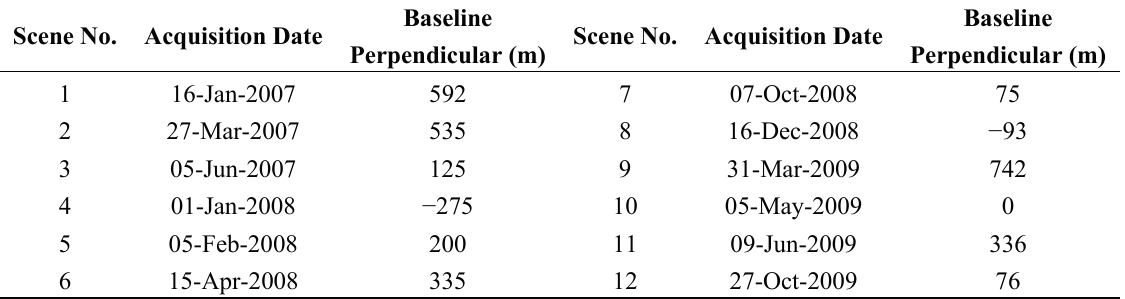
Table A2. SAR images used from Track 404 (Reference date: 05-September-2009). Scene